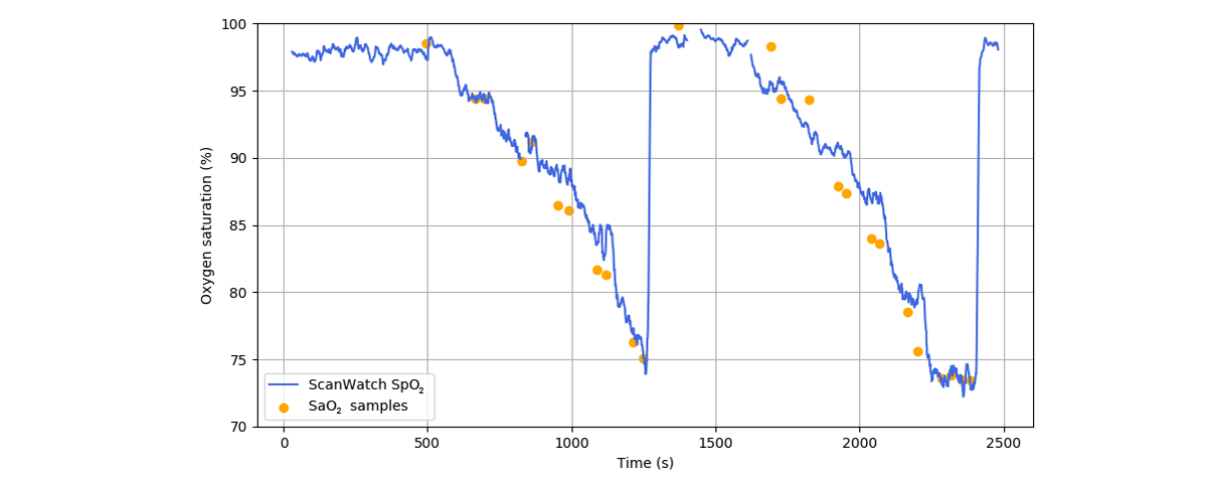
Figure 2. Comparison of SpO 2 measured by the ScanWatch and hemoximeter for one subject. SpO 2 : pulse oxygen saturation as measured by pulse